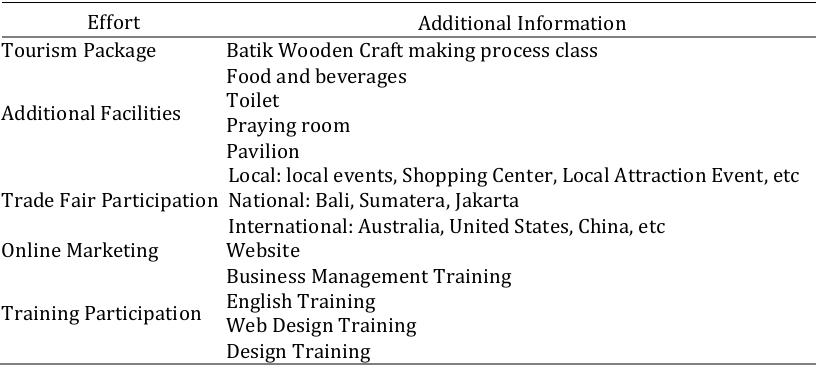
Table 6 Krebet Tourism Development